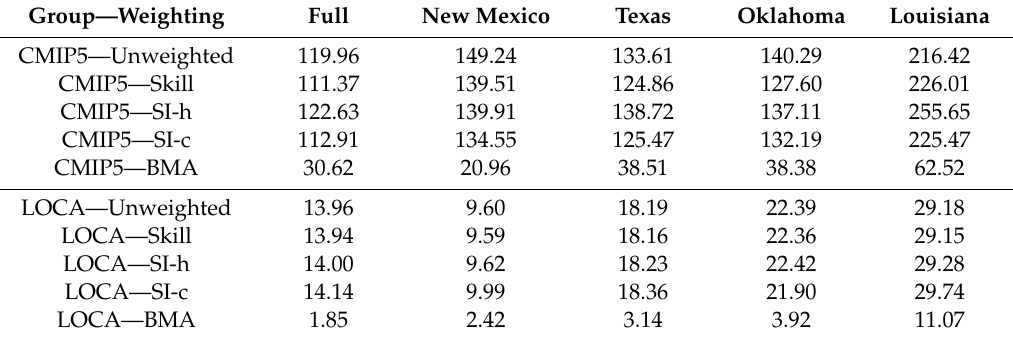
Table 1. Standard Deviation (mm) of Historical Ensemble Means—Unweighted CMIP5 and LOCA ensembles vs. weighted CMIP5 and LOCA ensembles for the full domain and all subdomains.